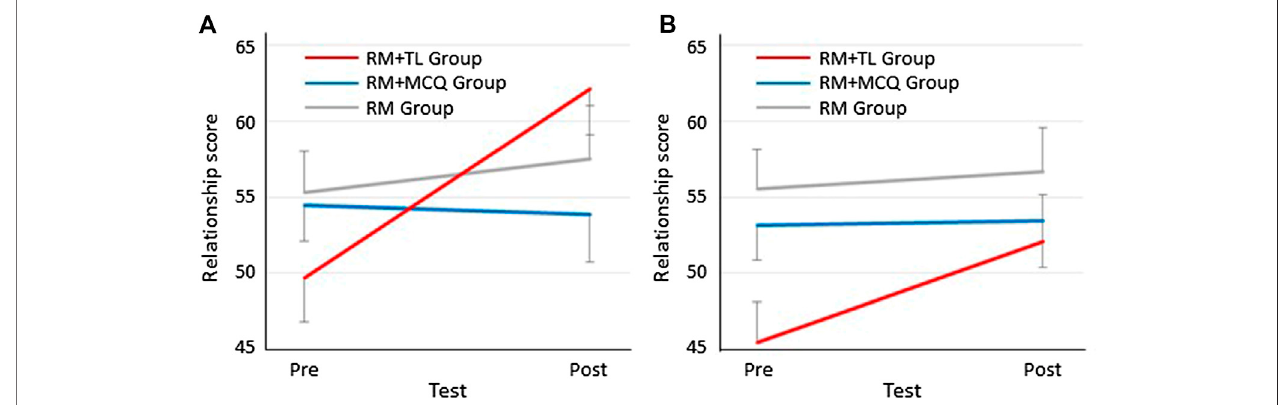
FIGURE 1 | (A) Words with collocation and (B) Words without collocation. Mean relationship score in each group before (Pre) and after (Post) the task. (Error bars indicate standard